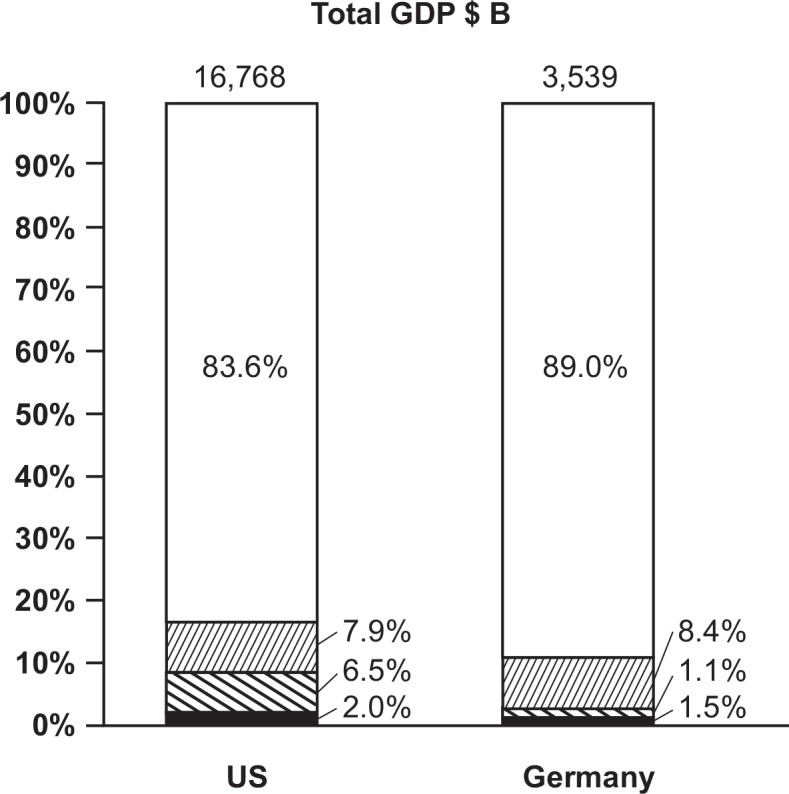
Percentage of public and private HCE of GDP (pie) in the US and Germany in 2013.Thin lines, public HCE; bold lines, private HCE without out-of-pocket; black fill, out-of-pocket HCE; white fill, rest of GDP (non-HCE) HCE, healthcare expenditure; GDP, gross domestic product; $B, US$ billion.